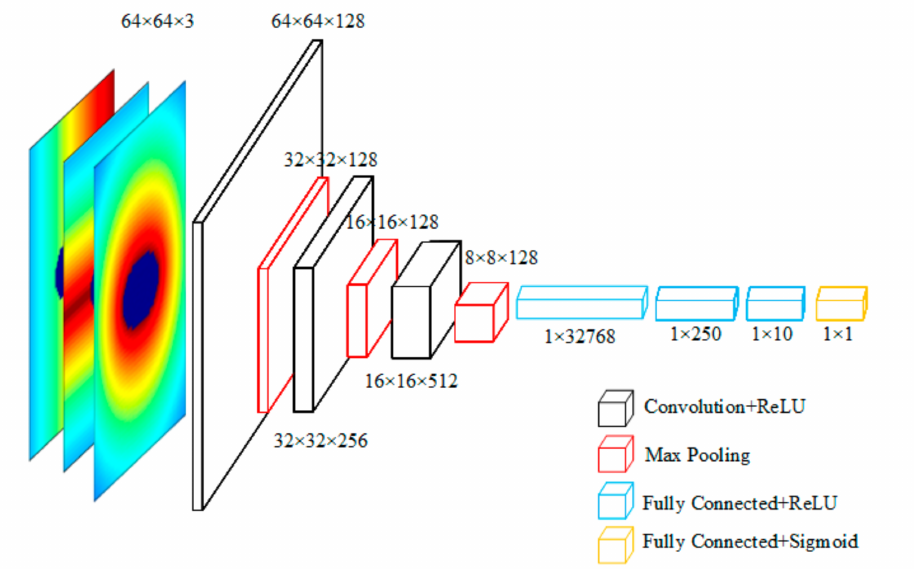
Figure 13. Determined CNN